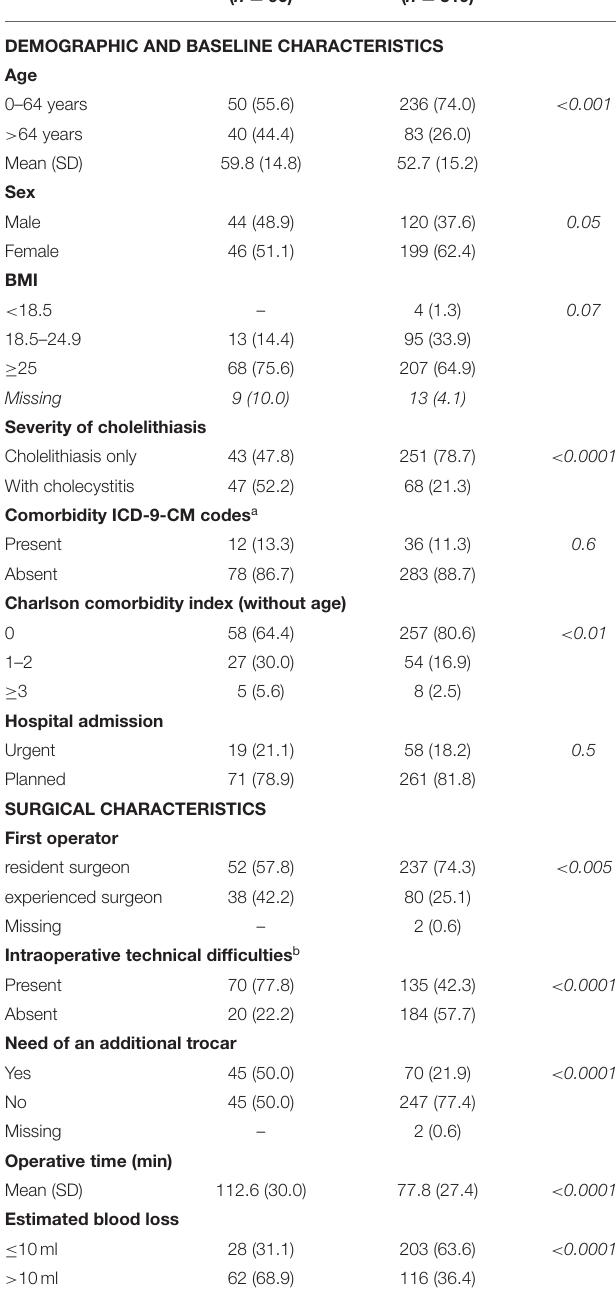
Group A (drain) Group B (no drain) ( n = 90) ( n =